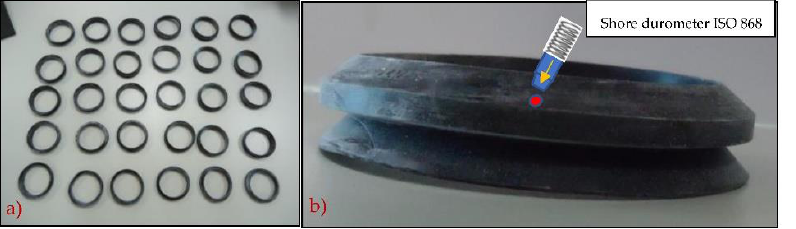
Figure 4. ( a ) Detailed of a batch of tested O-rings and ( b ) side view of O-ring and position of the Shore hardness indenter.